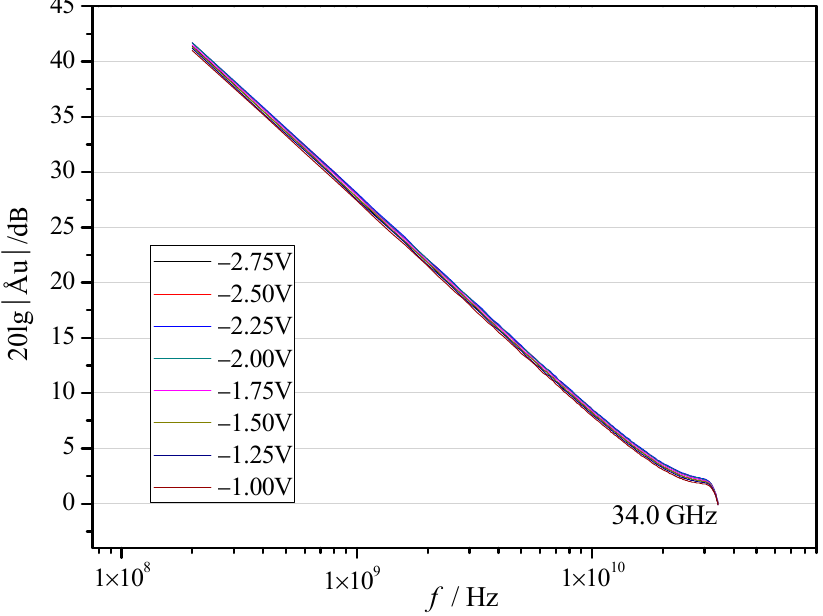
Figure 7. Small signal gain and cut-off frequency characteristics of conventional SiN-GaN HEMTs. Table 1. Small signal gain and cut-off frequency characteristics.